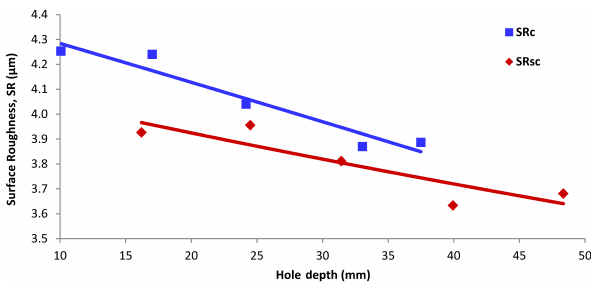
Figure 8. Results of MRR with respect to hole depth.